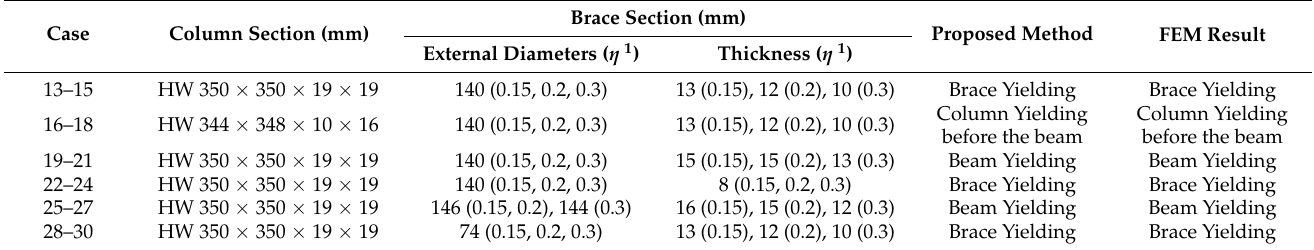
Table A1. Finite element verification results (top floor, η = 0.15, 0.2 and 0.3).